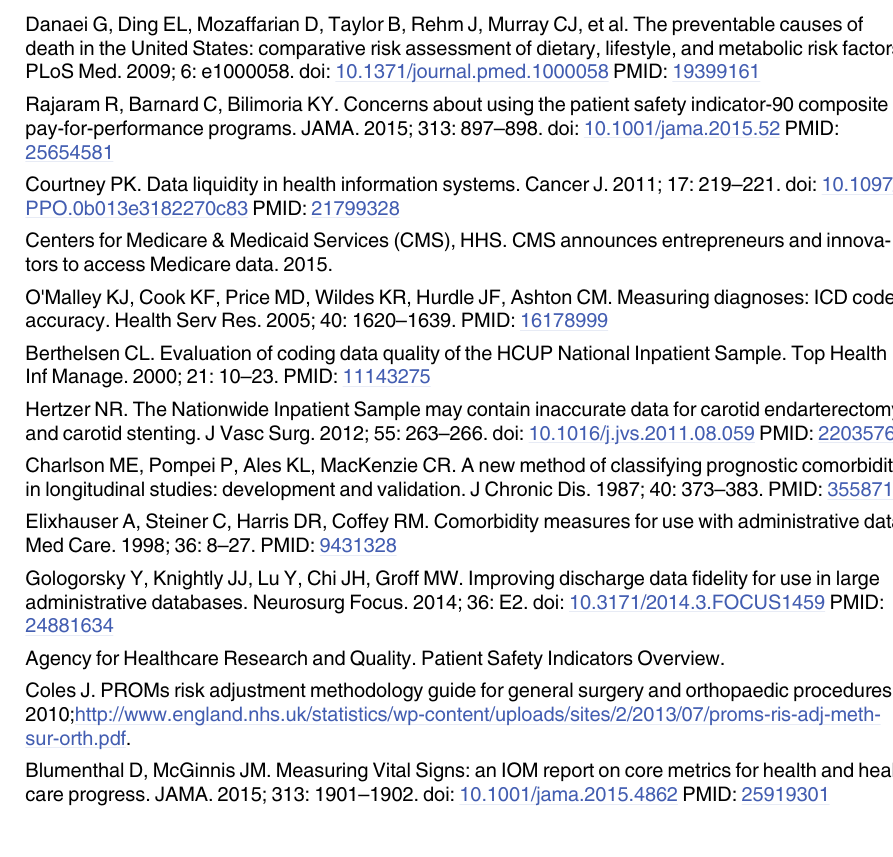
S1 Table. SAS code and definition of data elements used to estimate the prevalence. Con- tains the SAS codes and the definition of the data elements that were used in the statistical anal- ysis to estimate the prevalence of the risk factors at the national level and at the state level. S2 Table. Risk factors prevalence by state. Contains the weighted state-level prevalence for obesity (Table A), overweight (Table B), tobacco use (Table C) and alcohol abuse (Table D) in BRFSS and in